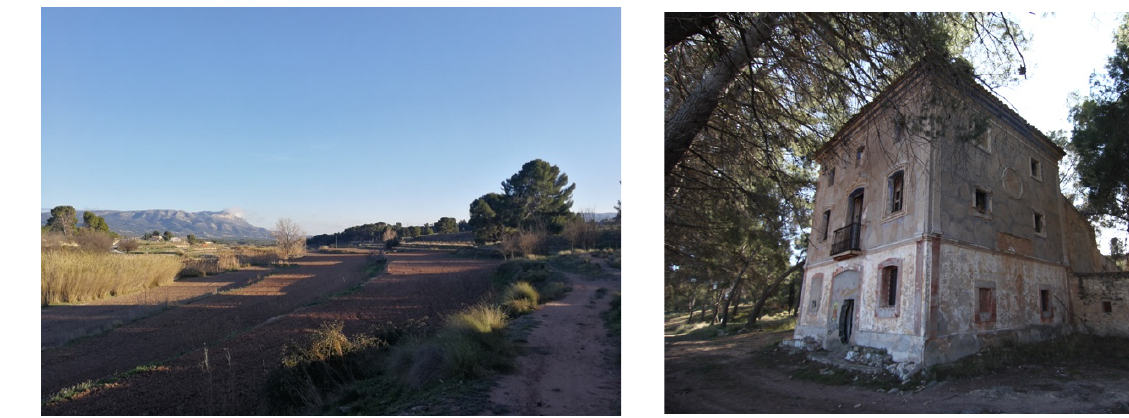
Figure 9. View of the Foia de Castalla district from the area of Casa de la Glorieta.